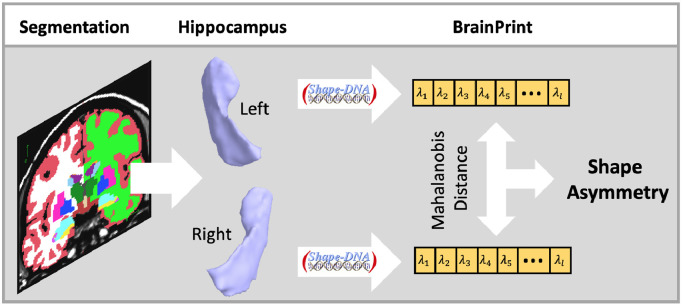
Graphical overview of steps for computing the brain asymmetry with the BrainPrint. MRI scans are segmented with FreeSurfer and meshes for the lateralized structure of interest, here hippocampus, are created. The computation of the shapeDNA results in the spectral shape descriptor in BrainPrint. The Mahalanobis distance between shape vectors yields measure of shape asymmetry.